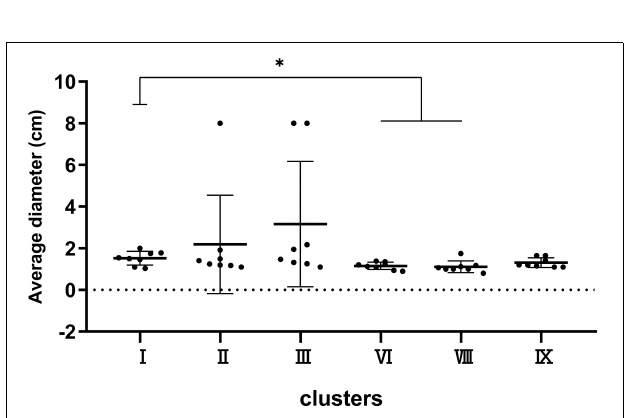
FIGURE 4 | Comparison of the biofilm formation capacity of strains in clusters VIII, VI, III, II, I, and IX. ∗ P < 0.05 means the biofilm formation capacity of clusters VIII, VI, III, I, and IX is significantly decreased compared to cluster II.